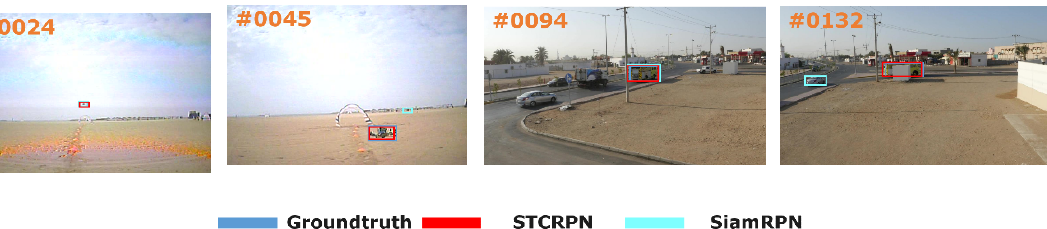
Figure 1. Comparison with the target groundtruth, SiamRPN and Spatial Cascaded Transformed Region Proposal Network (SCTRPN) on two sequences: It performs that the comparison between two different region proposal networks (RPN)-based methods in UAV123 dataset. The deep convolutional features can only be extracted to obtain the semantic information, it may easily drift away when suffering from the similar distractors and heavy occlusions.